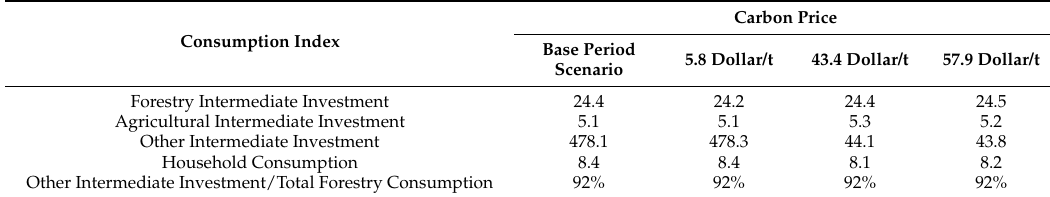
Table 4. Forestry consumption with different carbon prices (10 8